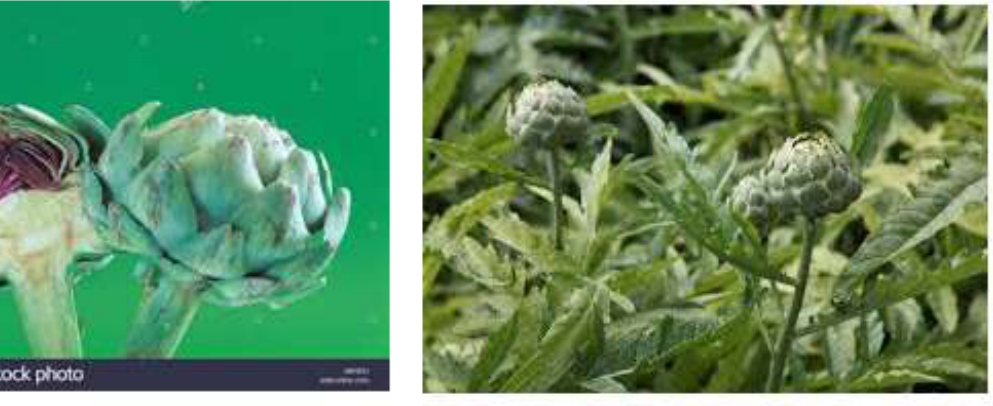
Figure 1. Fresh head(capsule) of Cynara scolymus